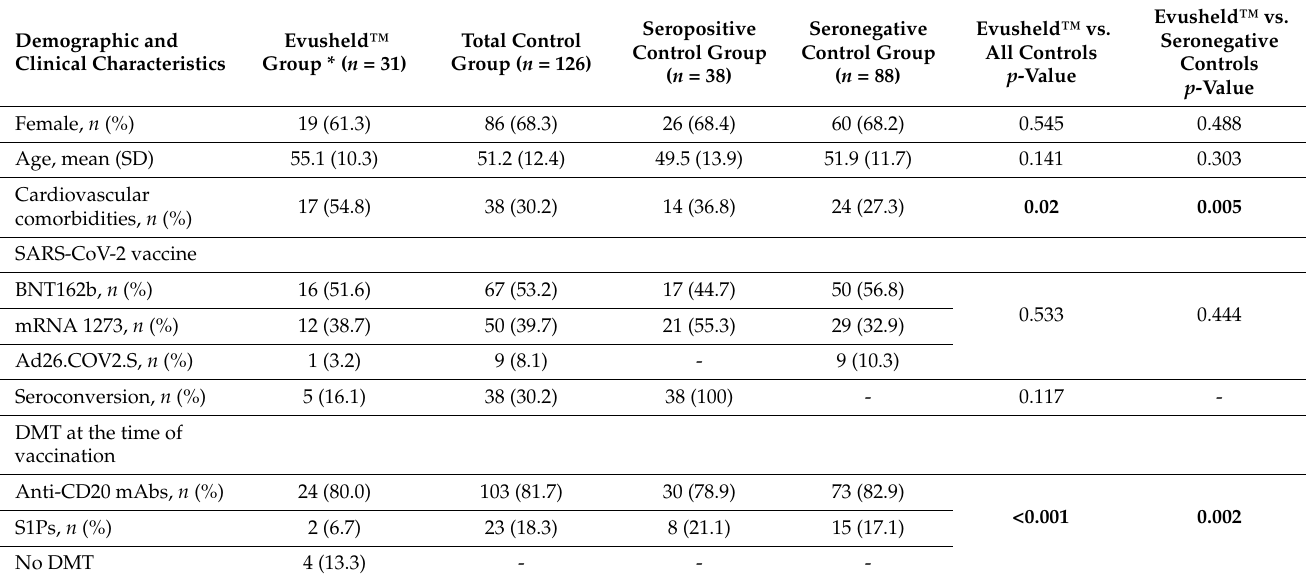
Table 1. Demographic and clinical characteristics of the pwNID study groups.